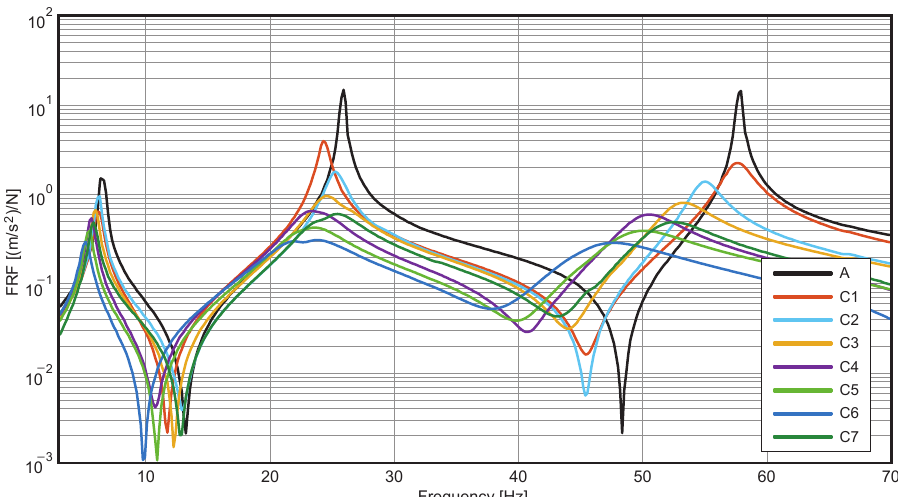
Figure 10. FRF of the reference beam (A) and configurations with honeycomb constraining layer (C).